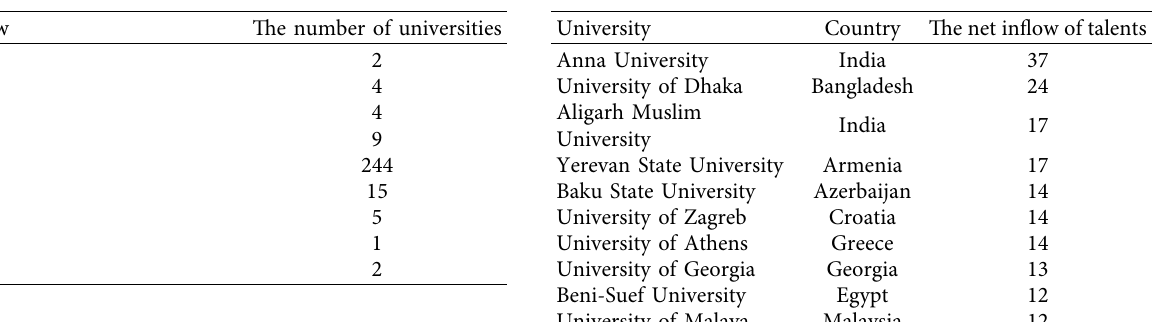
Table 5: The distribution of net talent flows of postgraduates.